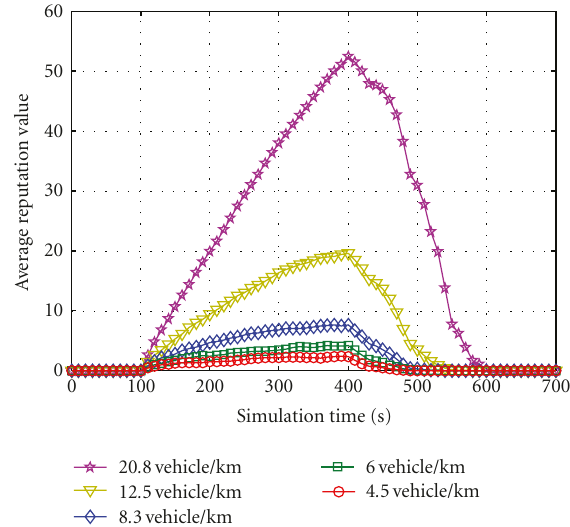
Figure 8: Fibonacci number function is adopted as the degradation function, D ( N te ) = Fibonacci ( N te ).